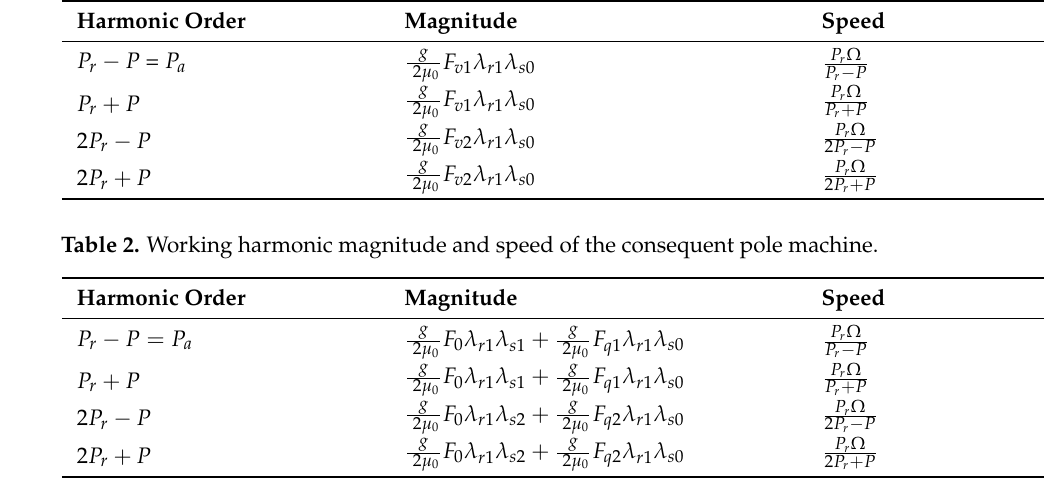
Table 1. Working harmonic magnitude and speed of the conventional machine. Harmonic Order